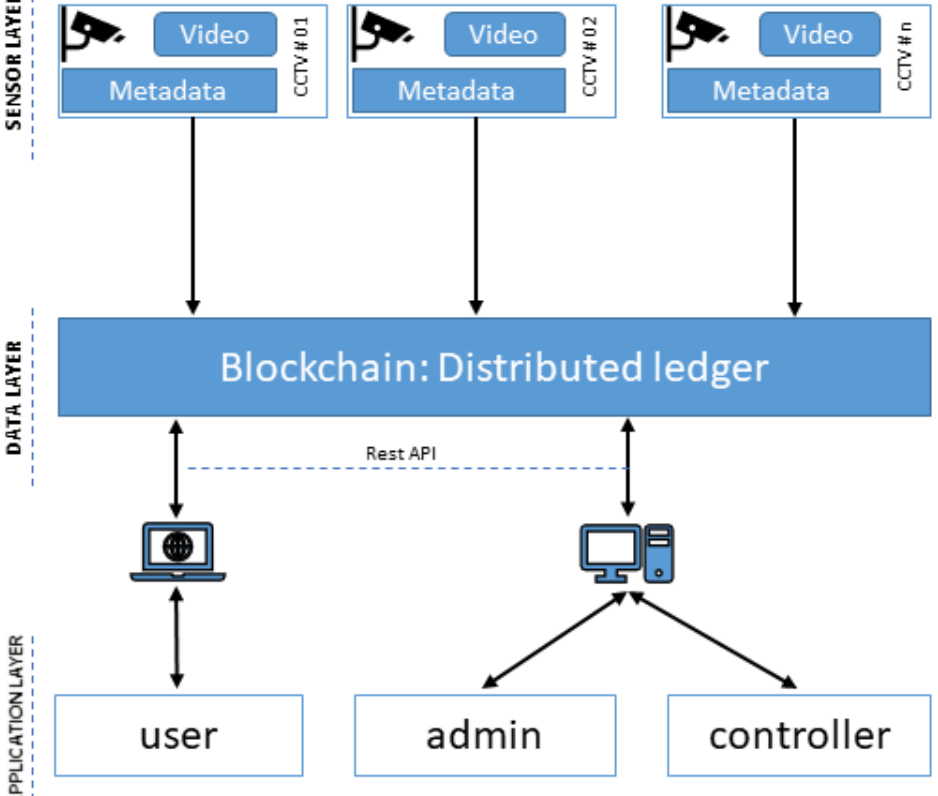
Figure 6. Blockchain-user interaction